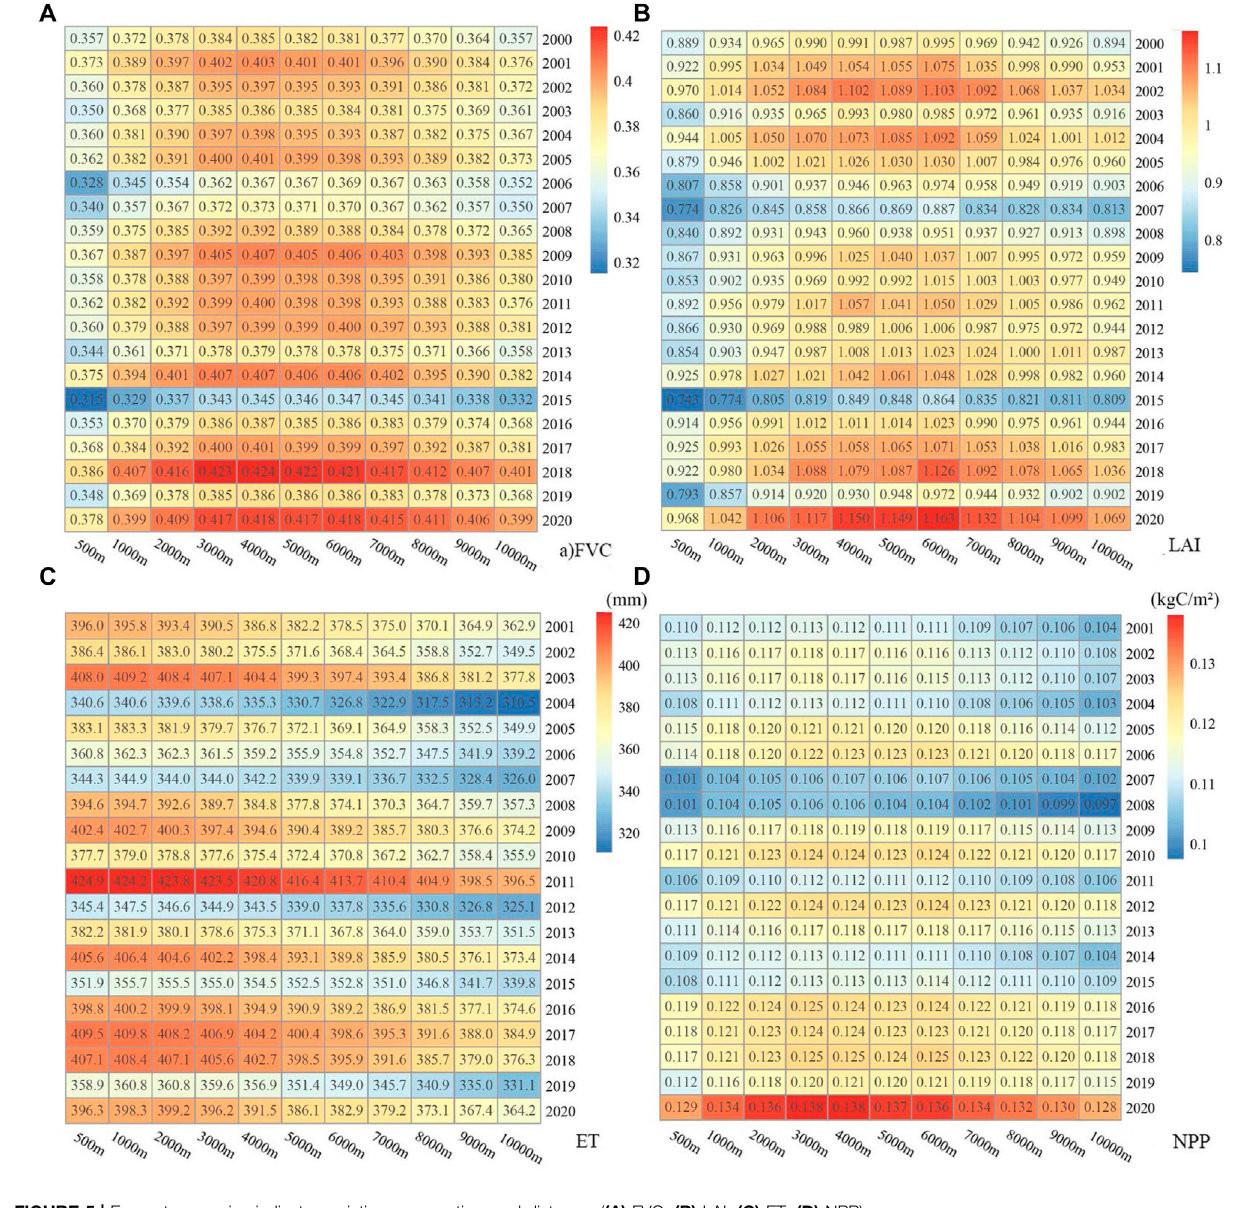
Frontiers in Environmental Science |